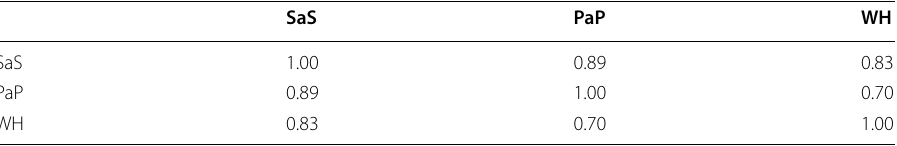
Table 5 The proposed ISC similarity scores among novels